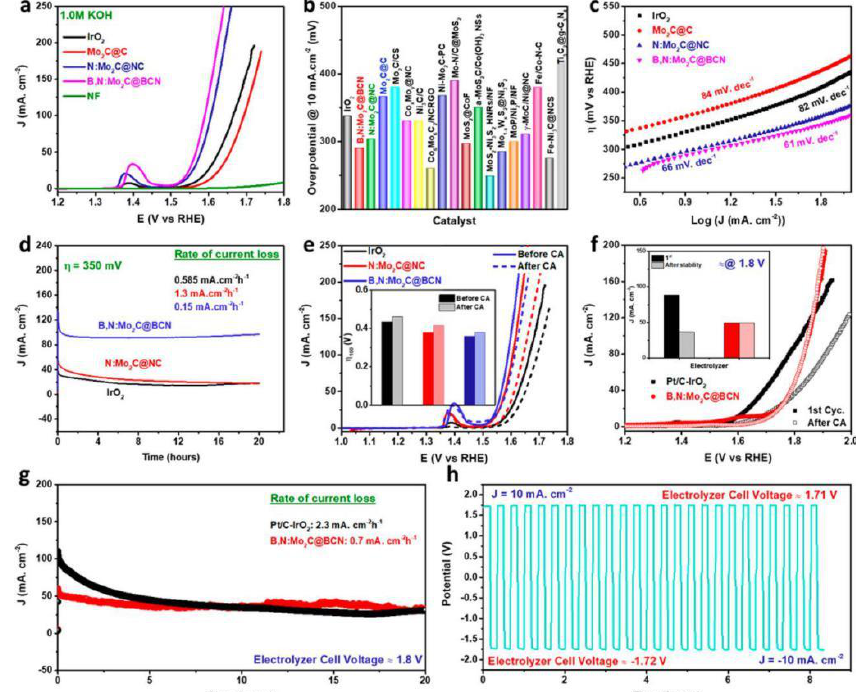
Figure 9. ( a ) OER IR-corrected polarization curves of Mo 2 C@C, N:Mo 2 C@NC, and B,N:Mo 2 C@BCN catalysts in 1.0 M KOH loaded on an NF electrode. ( b ) Comparison of η 10 values with other electrocatalysts based on Mo. ( c ) Tafel plots. ( d ) Electrode stability. ( e ) LSV curves and comparison of η 100 values (inset) before and after a 20-h durability test. ( f ) Polarization curves of a two-electrode electrolyzer using cathode-anode combinations of B,N:Mo 2 C@BCN-B, N:Mo 2 C@BCN, and Pt / C-RuO 2 @NF catalysts at a scanning rate of 2 mV / s and comparison of current densities at a cell voltage of 1.8 V before and after choronoamperometry (inset). ( g ) Electrolyzer stability test by choronoamperometry. ( h ) Pulse chronopotentiometric curve for H 2 / O 2 evolution in a B,N:Mo 2 C@BCN electrolyzer with the current density of − 10 / 10 mA · cm − 2 . The reversion time interval between the anode and cathode was 600 s in 1.0 M KOH solution. Reproduced with permission from [53]. Copyright 2018 American Chemical Society Catalysis